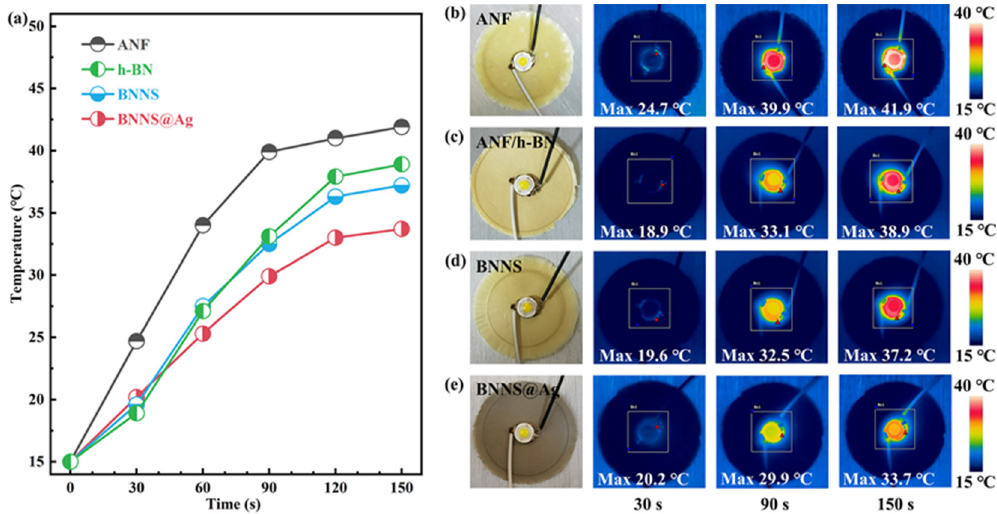
Figure 6. ( a ) The curves of surface temperature variation of the different composite films as a function of time upon heating. ( b – e ) Infrared thermal images of the different composite films.